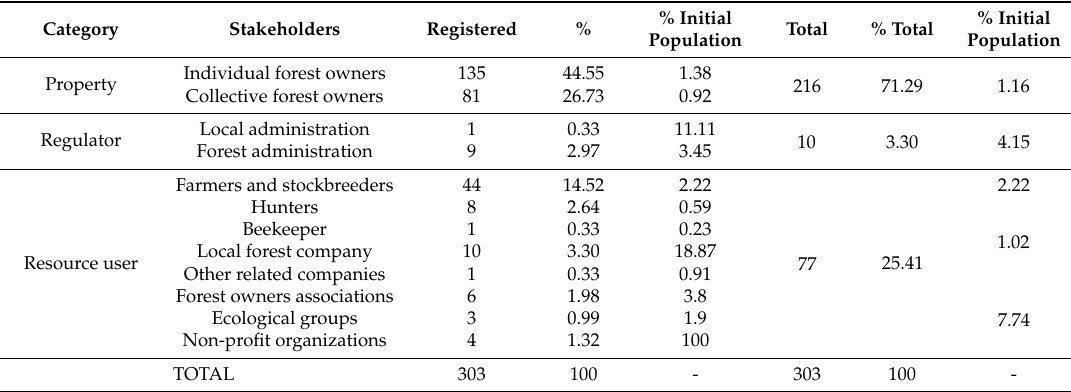
Table 7. Number of people registered in each interest group.